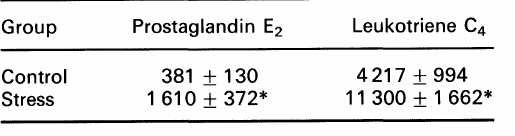
Table 1. Effect of stress on arachidonate products C, Group Prostaglandin E 2 Leukotriene Control 381 + 130 4 217 + 994 Stress 610 +_ 372* 11 300 662* Values are in ng/g/min and the mean-t-S.E.M, are